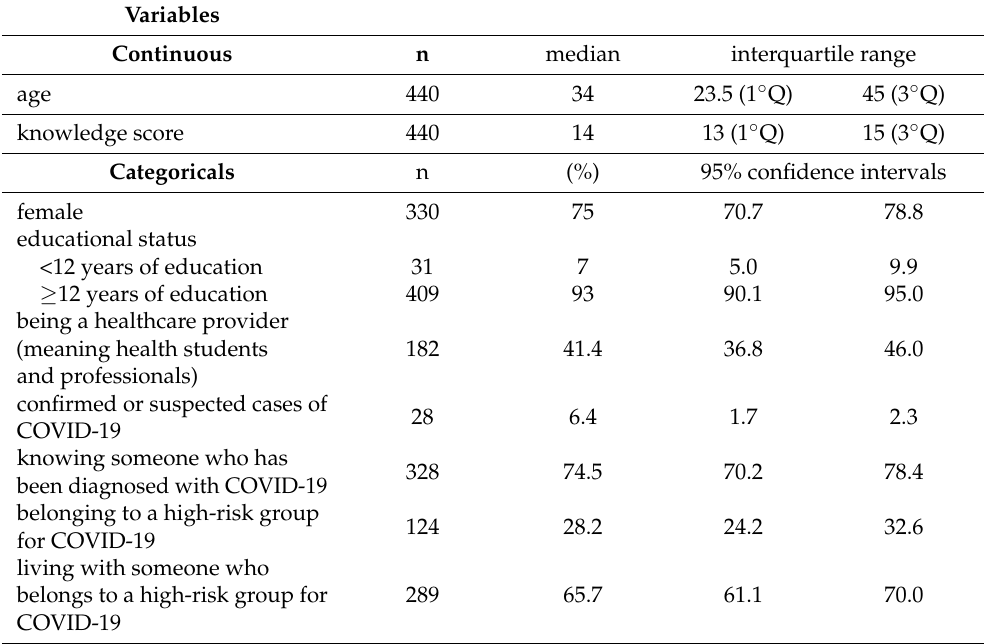
Table 1. Sociodemographic characteristics and factors associated with knowledge about COVID-19 among 440 Brazilian respondents.